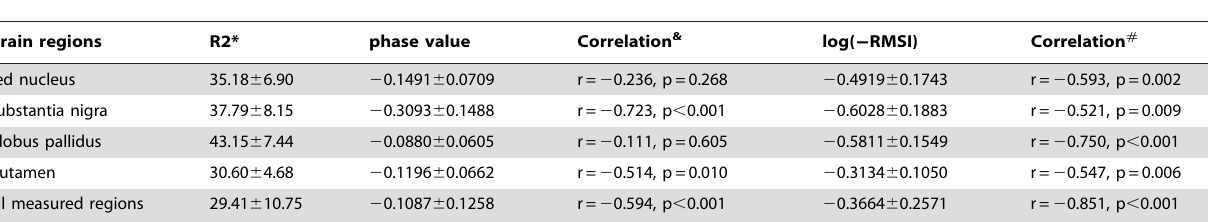
Table 1. R2*, phase values and log( 2 RMSI) (mean 6 SD) for each brain structure.